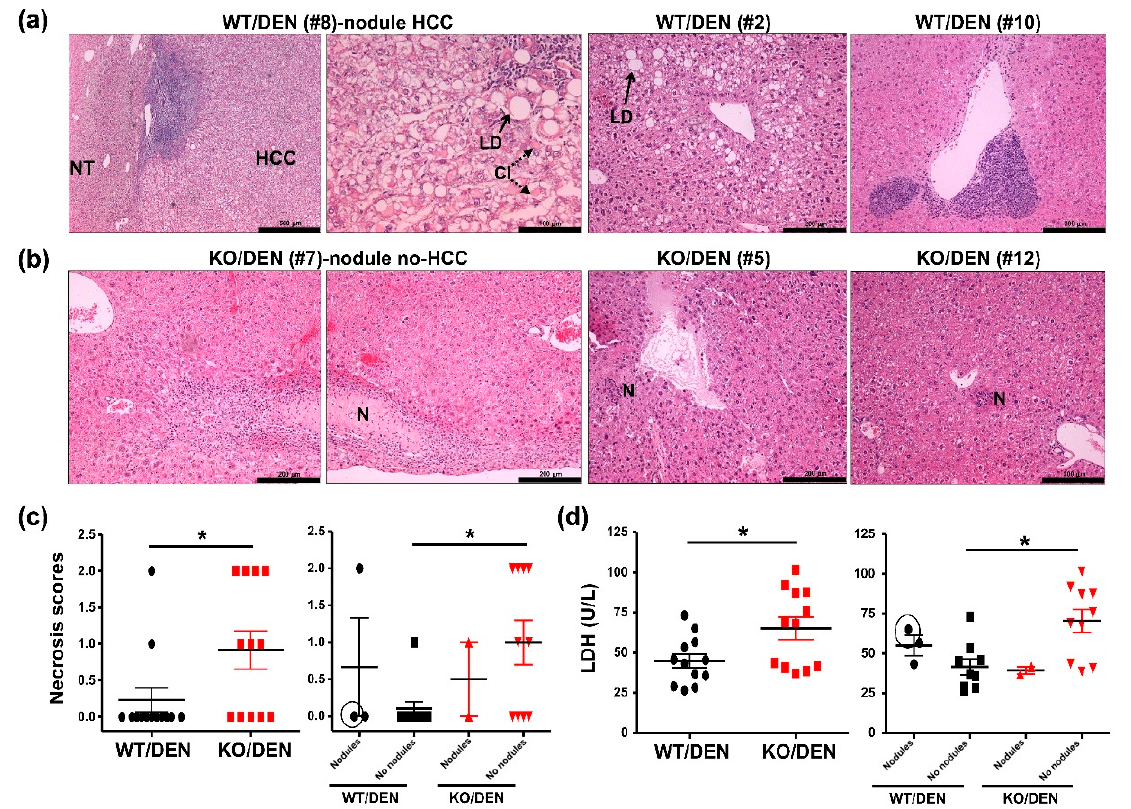
Figure 2. Mice were treated as described in Figure 1. ( a ) Histological evaluation of WT Mouse #8 mice treated with DEN showed tumor (HCC) bordering to normal tissue (NT). HCC cells were mixed with lipid droplets (LD indicated by a solid arrow), cytoplasmic inclusions (CI indicated by dotted arrows), and lymphoplasmacellar infiltration. Other abnormalities in DEN-treated WT mice were fatty changes (Mouse #2) and heteromorphous population of lymphocytes suspicious for lymphoma (Mouse #10). ( b ) Histological evaluation of livers of DEN-treated KO mice showed a compressed necrotic (N) area in hyperplastic nodule of Mouse #7. Focal hepatic necrosis was evident in Mouse #5 and Mouse #12. ( c ) Necrosis histology scores in livers outside the nodules obtained from total number of mice (left) and mice with ‘Nodules’ or ‘No nodules’ (right). ( d ) Plasma LDH (U/L) levels obtained from total number of mice (left) and mice with ‘Nodules’ or ‘No nodules’ (right). The value with a black circle was from DEN-treated WT Mouse #8. Data are mean ± SEM; N = 12–13. *, p < 0.05 with Mann-Whitney U tests.